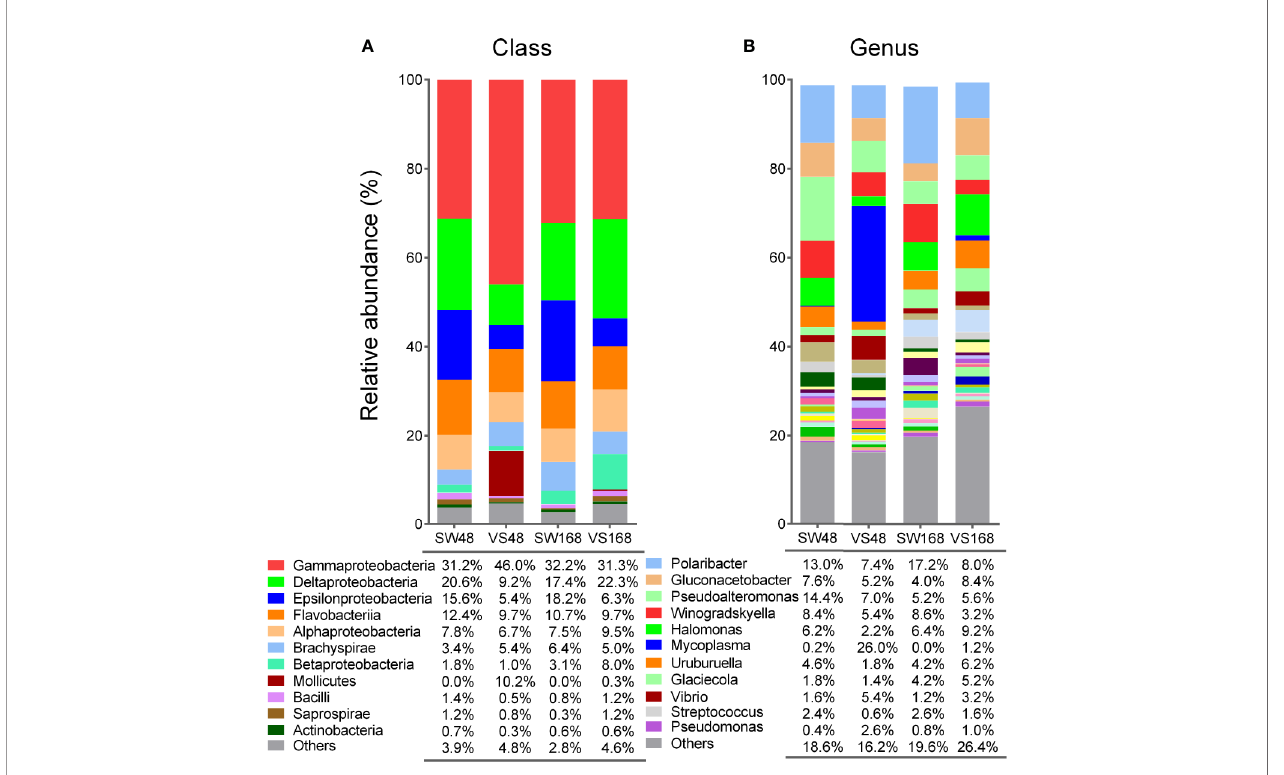
FIGURE 2 | Relative abundances of bacterial groups present in scallop hemolymph after immune stimulation determined by 16S rDNA deep amplicon sequencing. Stack bar graphs indicate the average relative abundance of major bacterial groups found in Vibrio -injected scallops (VS) and seawater-injected scallops (SW) after 48 h and 168 h, at class (A) and genus (B) taxonomic levels. Bacterial groups with relative abundances higher or closer to 1% are shown for each taxonomic